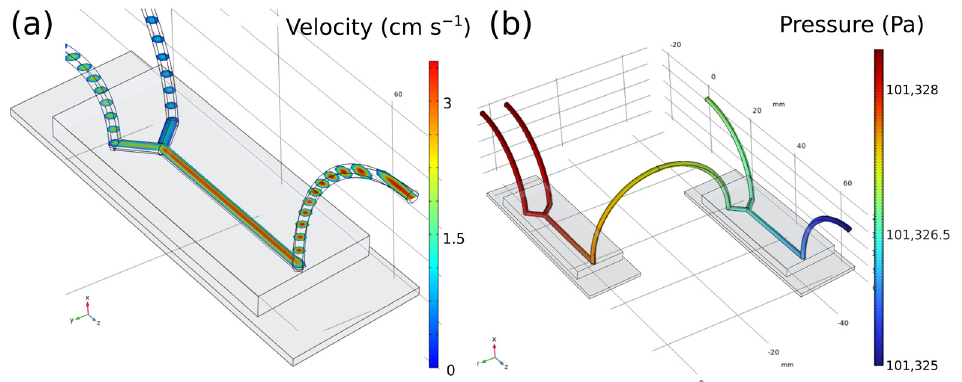
Figure 1. Computational fluid dynamics (CFD) from a simple chip ( a ) and the system of two connected in series ( b ). In the first image a) the flow velocity inside the channels of the second microchip can be seen. As expected, a greater magnitude is found in the center of the section, decreasing as it moves away from it, radially. The second image ( b ) depicts the pressure changes, and it can be concluded that there are no large pressure changes throughout the system that could influence the correct mixture of the